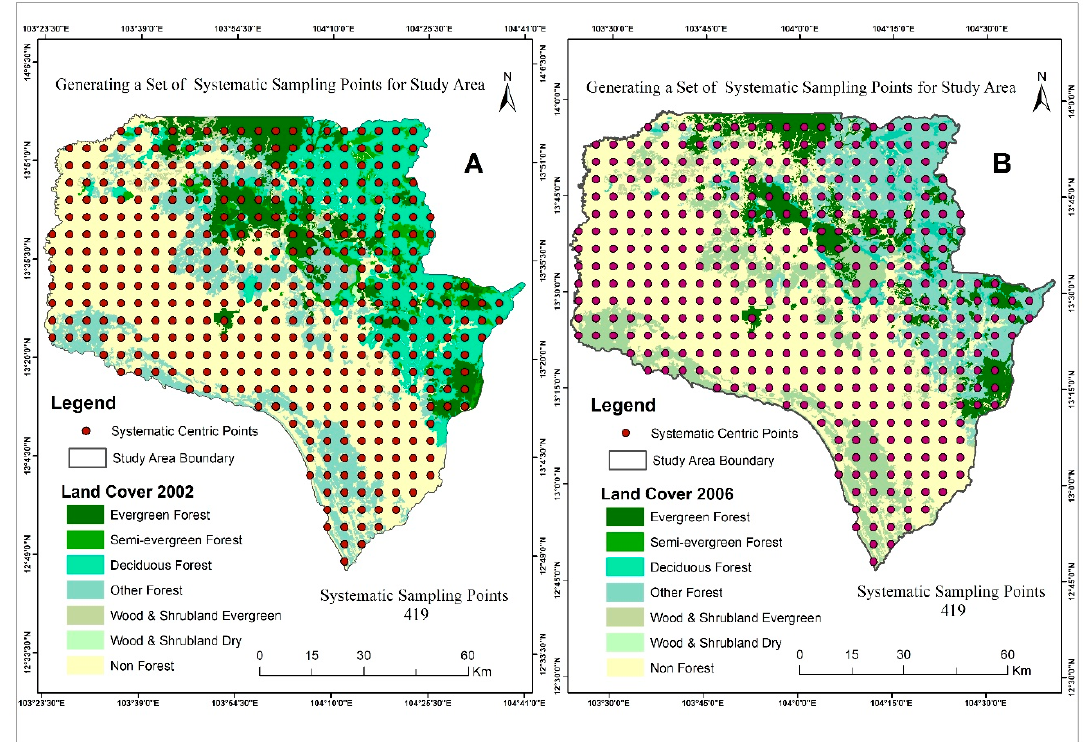
Figure 3. Map showing the systematic (5 × 5 km) centric sampling points using Esri’s ArcMap for PBTC map ( A ) and reference land cover map ( B ) [10,59].